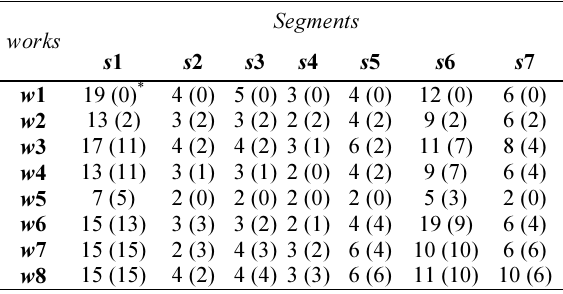
Fig. 2. Fragment of a solution graph for data from Example 1 Table 1. Total times of actions on working segments and over- laps values represented as